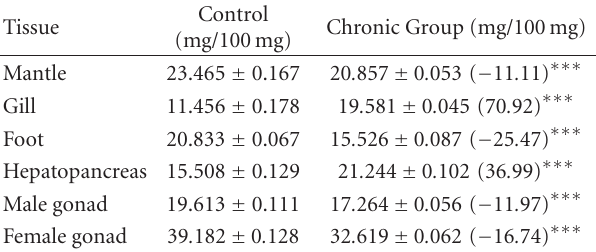
Table 2: Cypermethrin induced alterations in the total glycogen content of K. opima after chronic exposure. (Results expressed in mg/100mg dry wt.